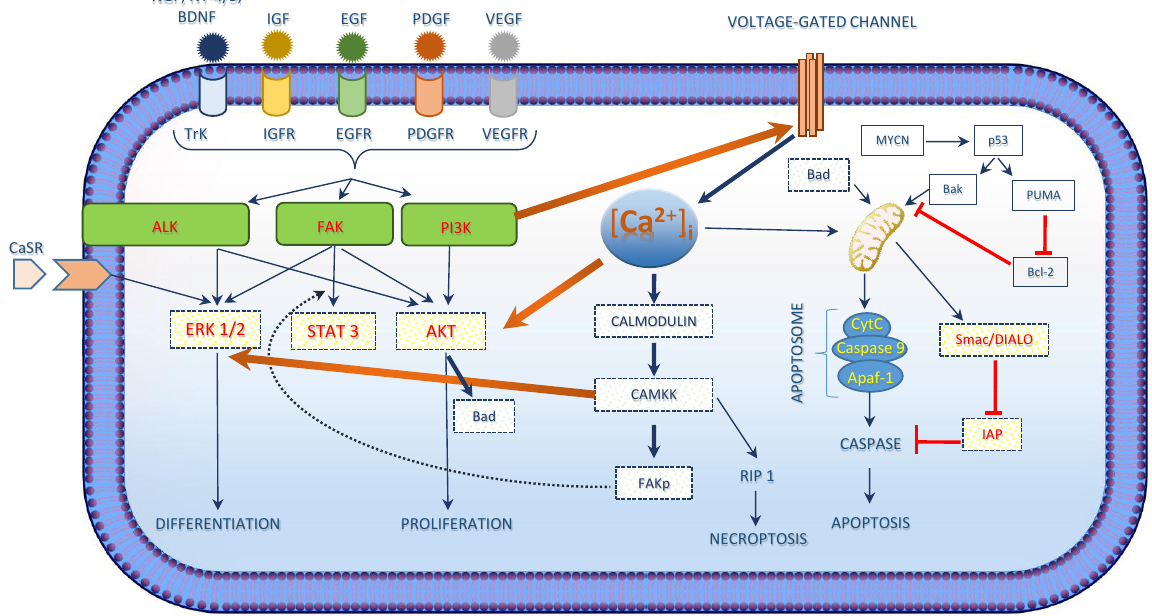
Figure 3. Intracellular calcium and cell survival: Intracellular calcium activates the intermediate proteins in the signalling pathways in neuroblastoma. Figure illustrates calcium regulating three kinases (AKT, ERK and FAK) that are involved in the cell survival signalling in neuroblastoma. The intracellular calcium and PI3K/AKT pathway influences one another forming a loop, while its impact on other two kinases is mainly via the activation of calmodulins and the CaM dependent protein kinase kinase.